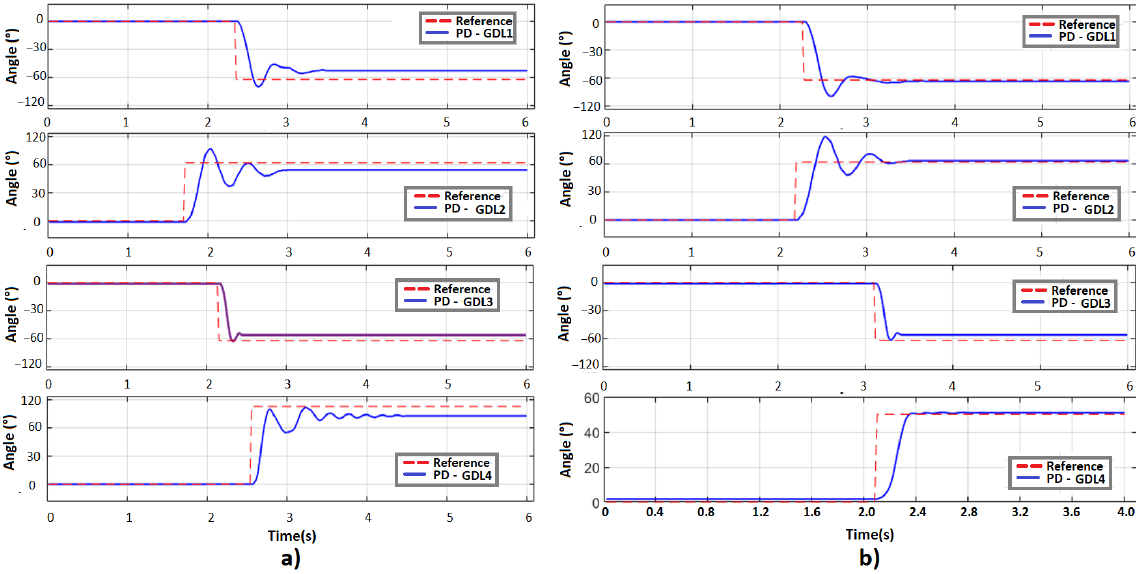
Figure 18. Position regulation for the 4 DOF for left arm: ( a ) only PD; ( b ) PD with gravity